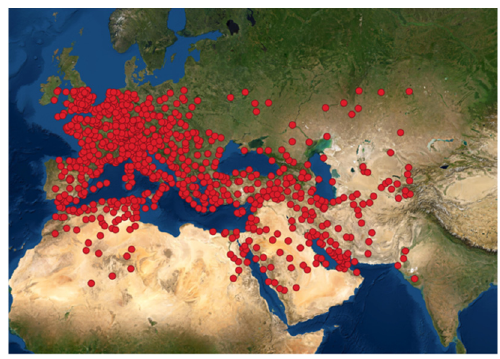
Figure 2. Locations of MADIS stations reporting measured atmospheric data on 18 September 2020 at 00 UTC.